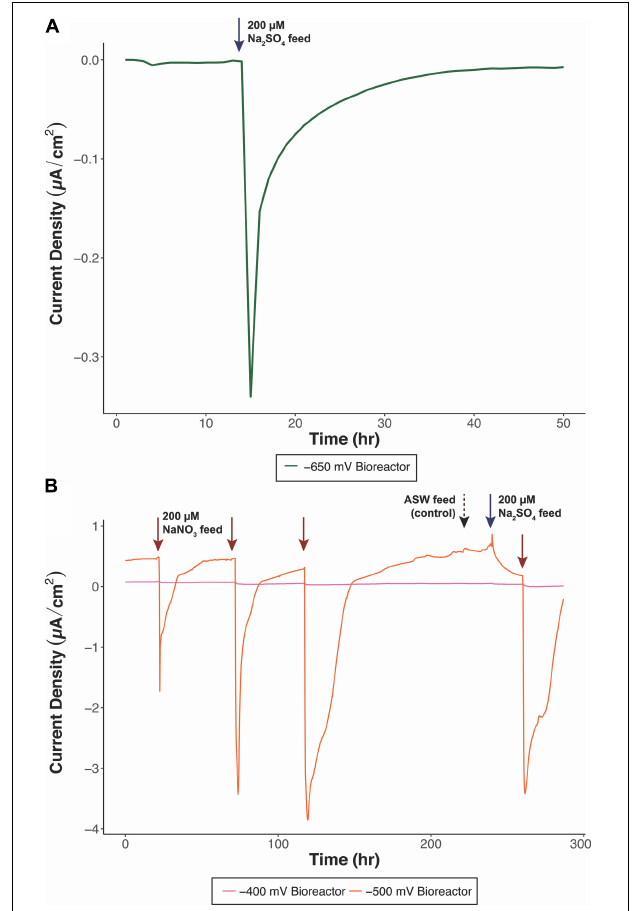
FIGURE 1 | Representative chronoamperometry profiles of electrochemical bioreactors, (A) –650 mV (vs. Ag/AgCl) bioreactor fed with sulfate as TEA and (B) –400 mV (orange) and –500 mV (pink) (vs. Ag/AgCl) bioreactors fed with nitrate as the primary TEA. Blue arrows indicate sulfate feeds, red arrows indicate nitrate feeds, and the black dashed arrow indicates an artificial seawater base feed. Sulfate and nitrate additions correspond to a final concentration of 200 µ